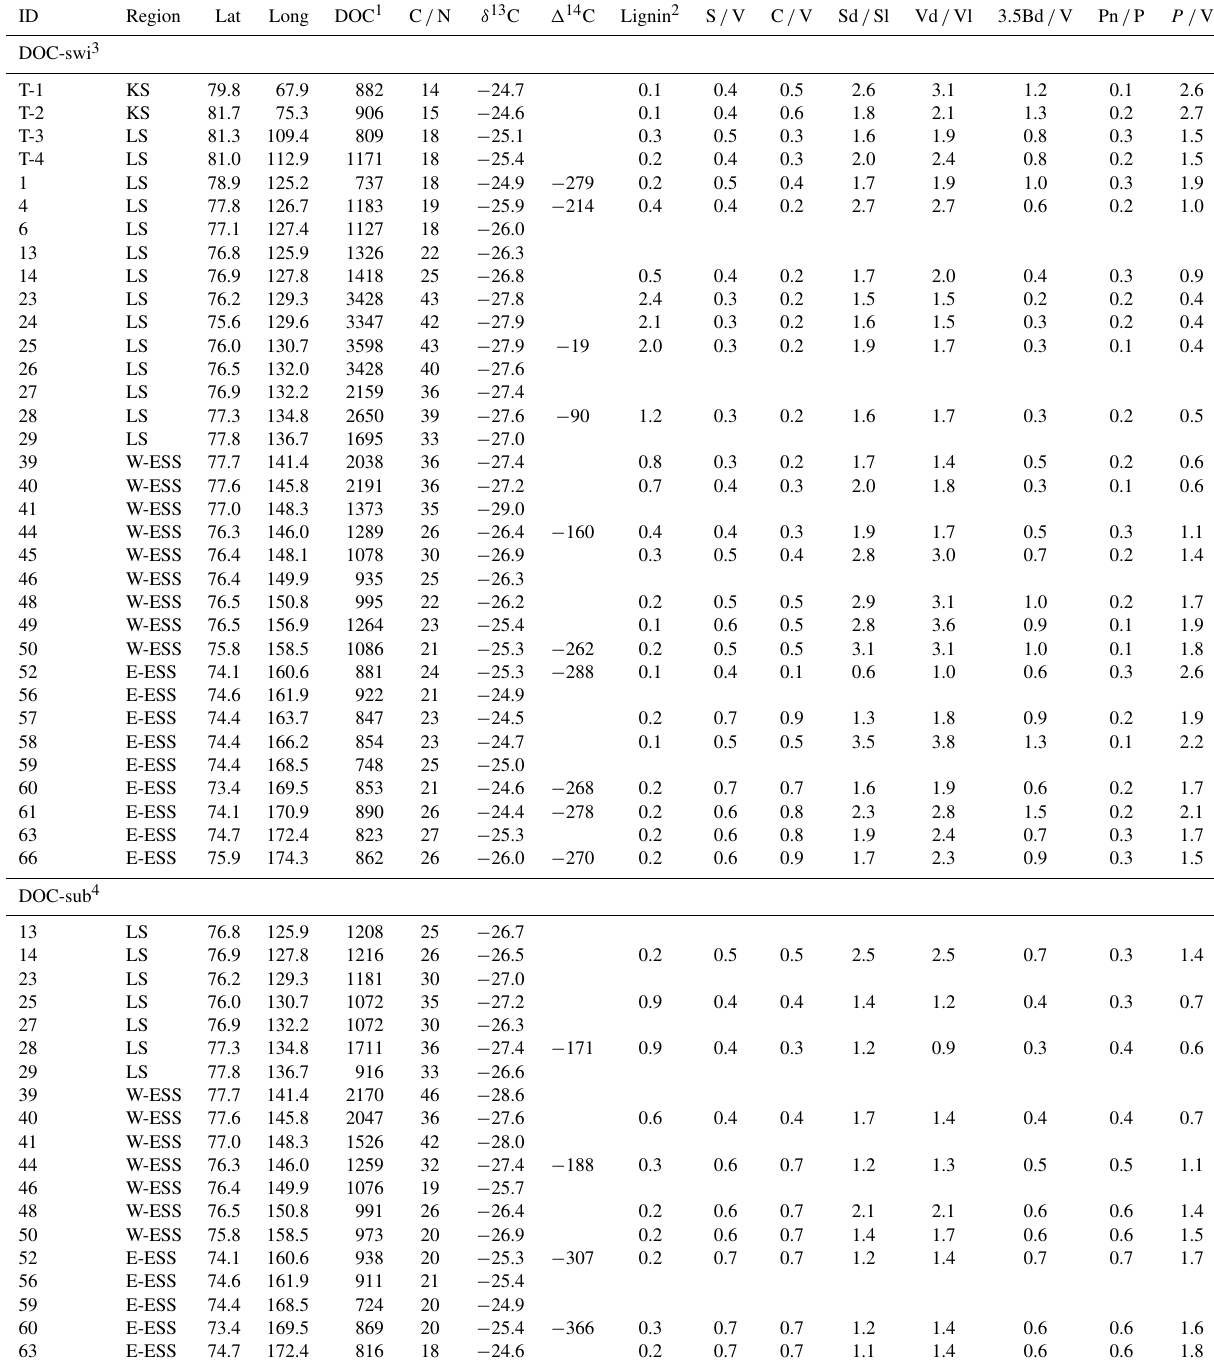
Table 1. Composition of surface and near-bottom DOC samples collected in the outer Eurasian Arctic Shelf.